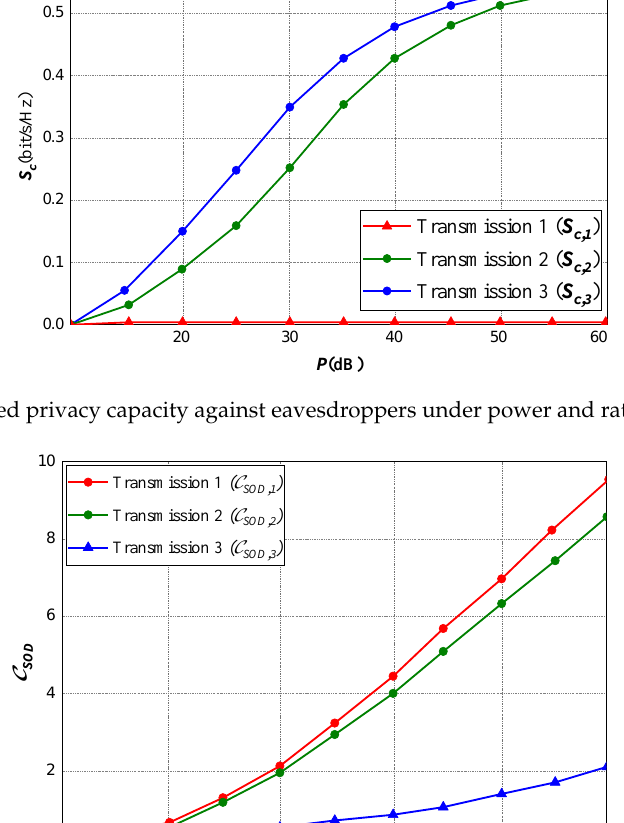
Figure 4. Realized privacy capacity for Source-to-Destination ( C ∗ power and rate